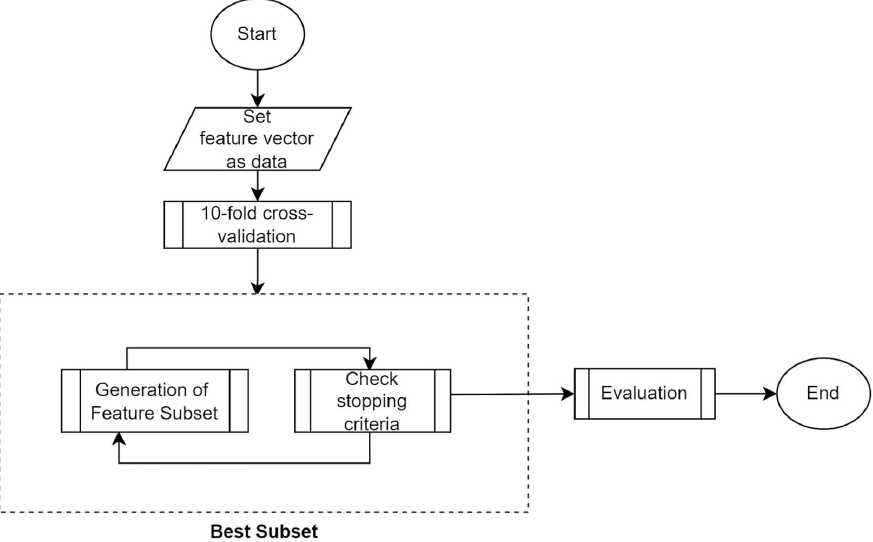
Figure 3. FFS block diagram.